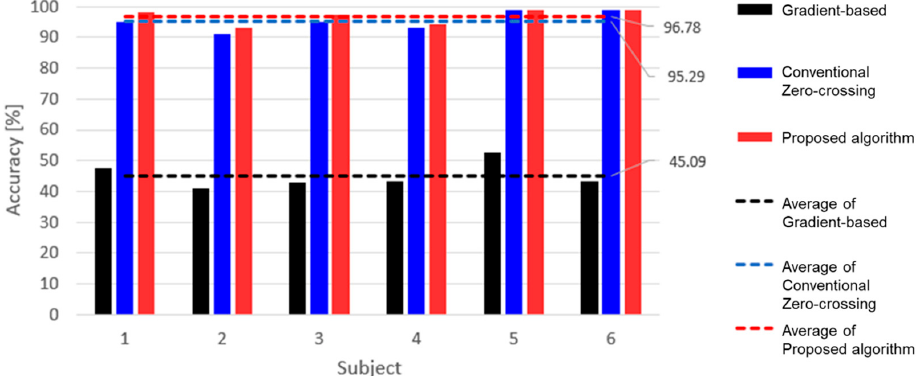
Figure 7. Peak detection accuracy of the gradient-based, the conventional zero-crossing, and the proposed peak detection algorithms.